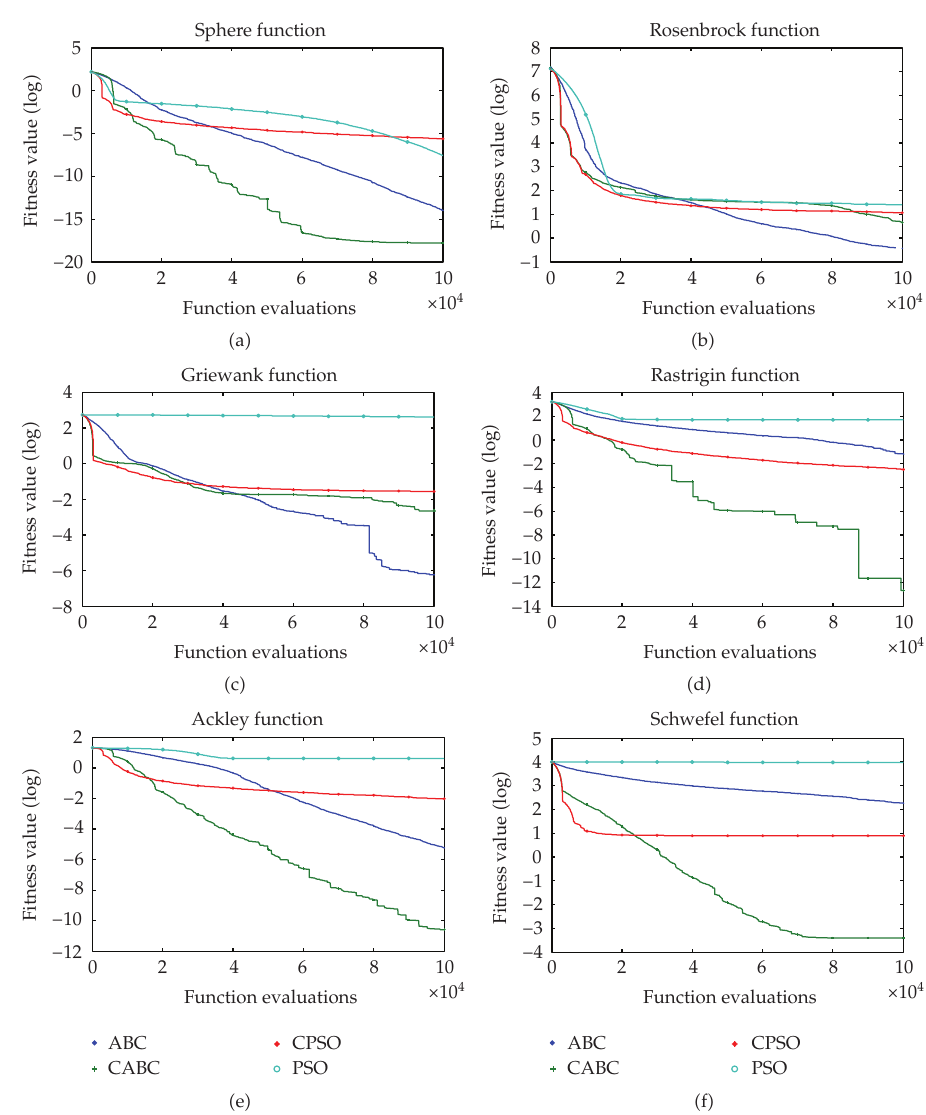
Figure 1: The median convergence characteristics of fitness functions. (cid:2) a (cid:3) Sphere function. (cid:2) b (cid:3) Rosenbrock function. (cid:2) c (cid:3) Griewank function. (cid:2) d (cid:3) Rastrigin function. (cid:2) e (cid:3) Ackley function. (cid:2) f (cid:3) Schwefel